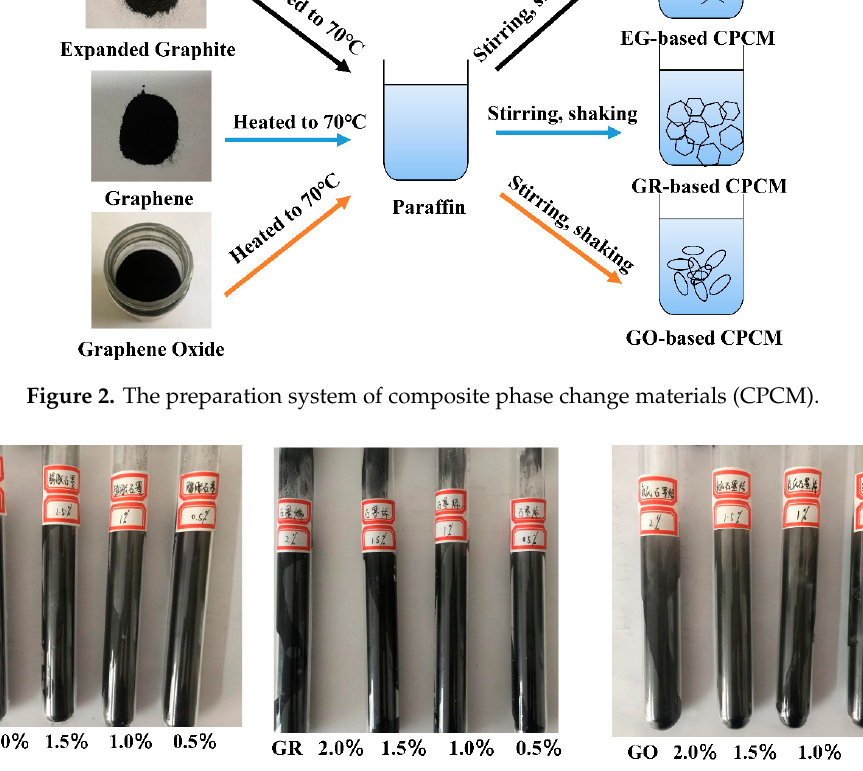
Figure 4. Experiment system.